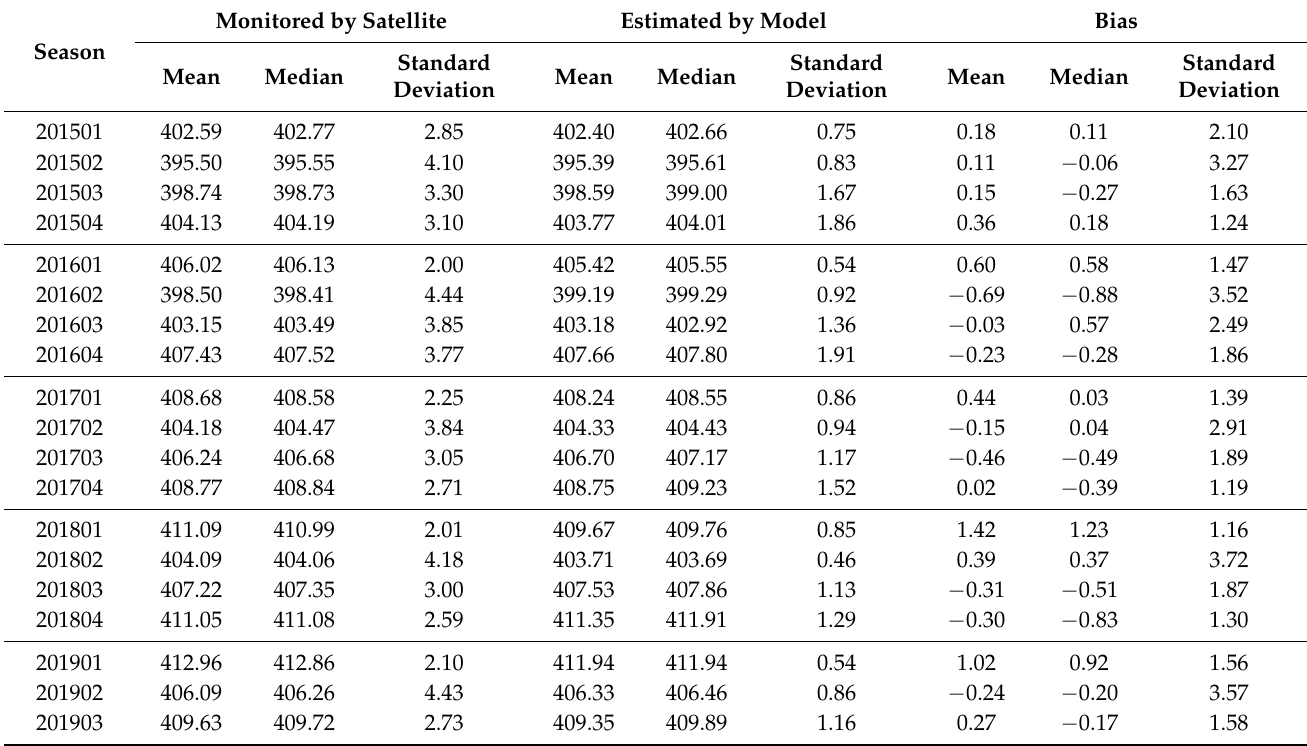
Table 4. Statistical results of the seasonal mean values of the XCO 2 concentration monitored by the OCO-2 satellite and the XCO 2 concentration estimated by the random forest